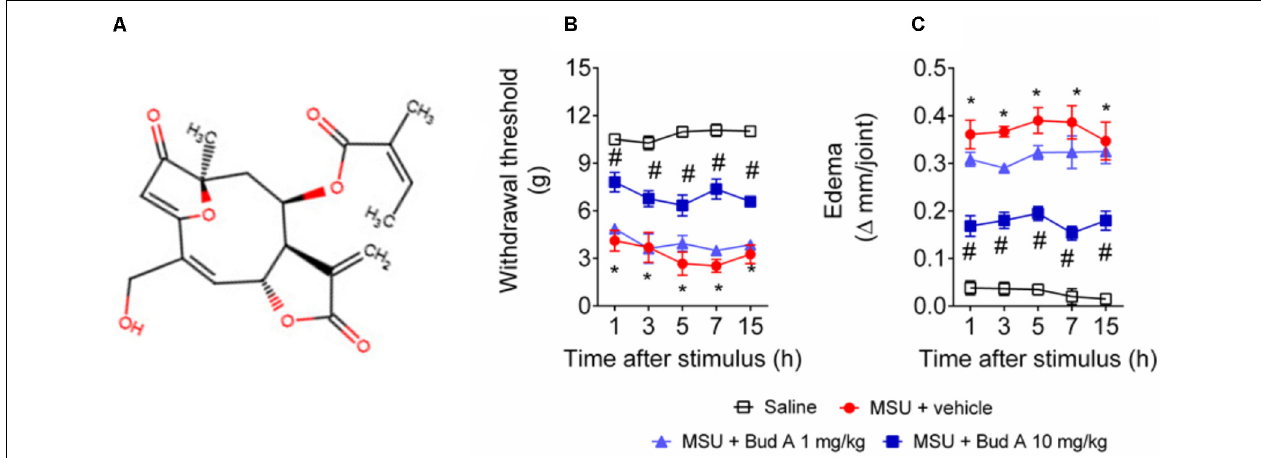
FIGURE 1 | Budlein A decreases MSU-induced mechanical hypersensitivity and knee joint edema. Chemical structure of Budlein A is represented in panel (A) . The molecule was drawn using Marvin JS, MarvinSketch in JavaScript. Mechanical hypersensitivity (B) and knee joint edema (C) were evaluated 1, 3, 5, 7, and 15 h after the injection of MSU crystals using electronic von Frey and caliper, respectively. ∗ p < 0.05 vs. saline group; # p < 0.05 vs. 0 mg/kg group, two-way repeated measures ANOVA followed by Tukey’s post hoc .